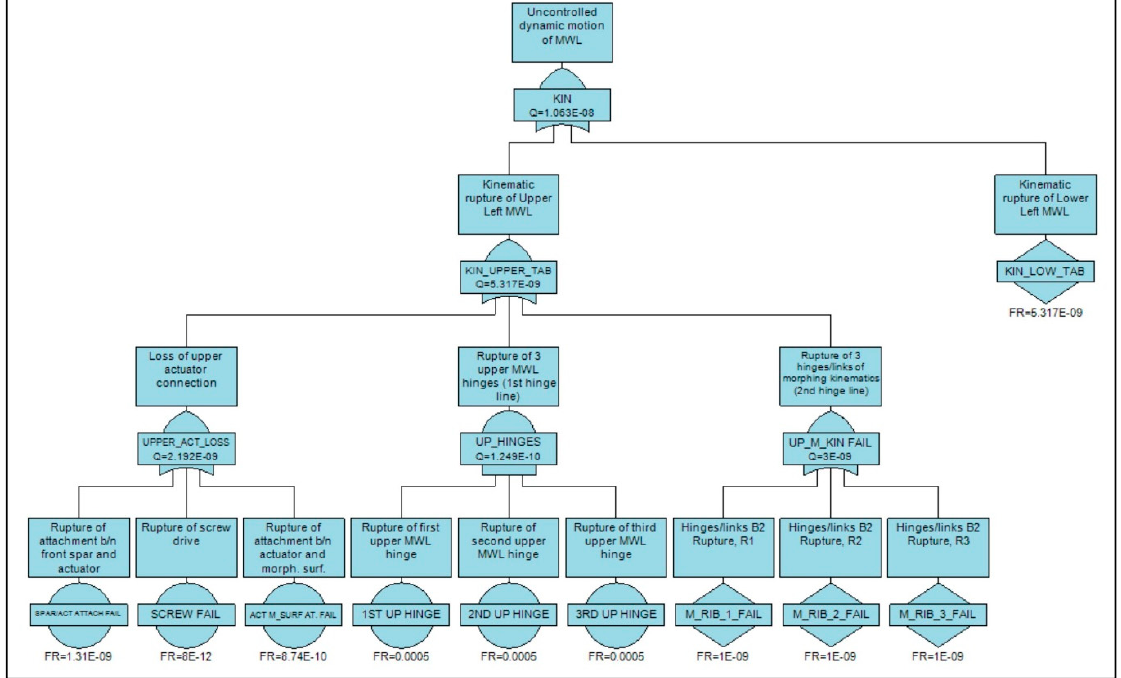
Figure 8. Morphing winglet—uncontrolled dynamic motion (left or right) fault tree analysis.